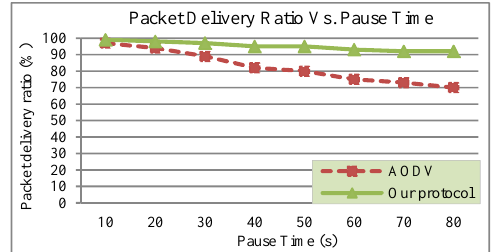
Fig. 7. Packet Delivery Ratio Vs. Pause Time